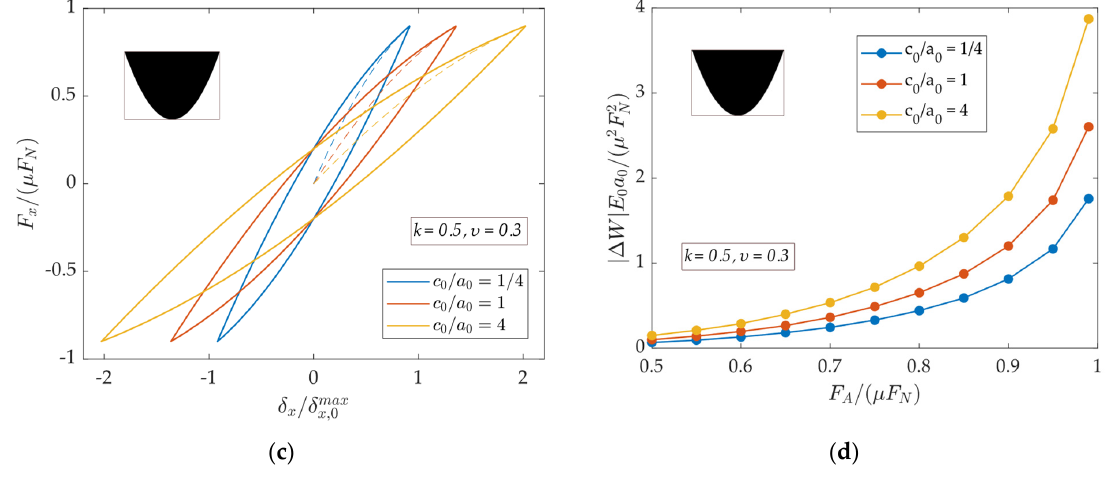
for (cid:1863) = −0.5 ; (cid:3091)(cid:3007) (cid:3263) for k = − 0.5; µ F N